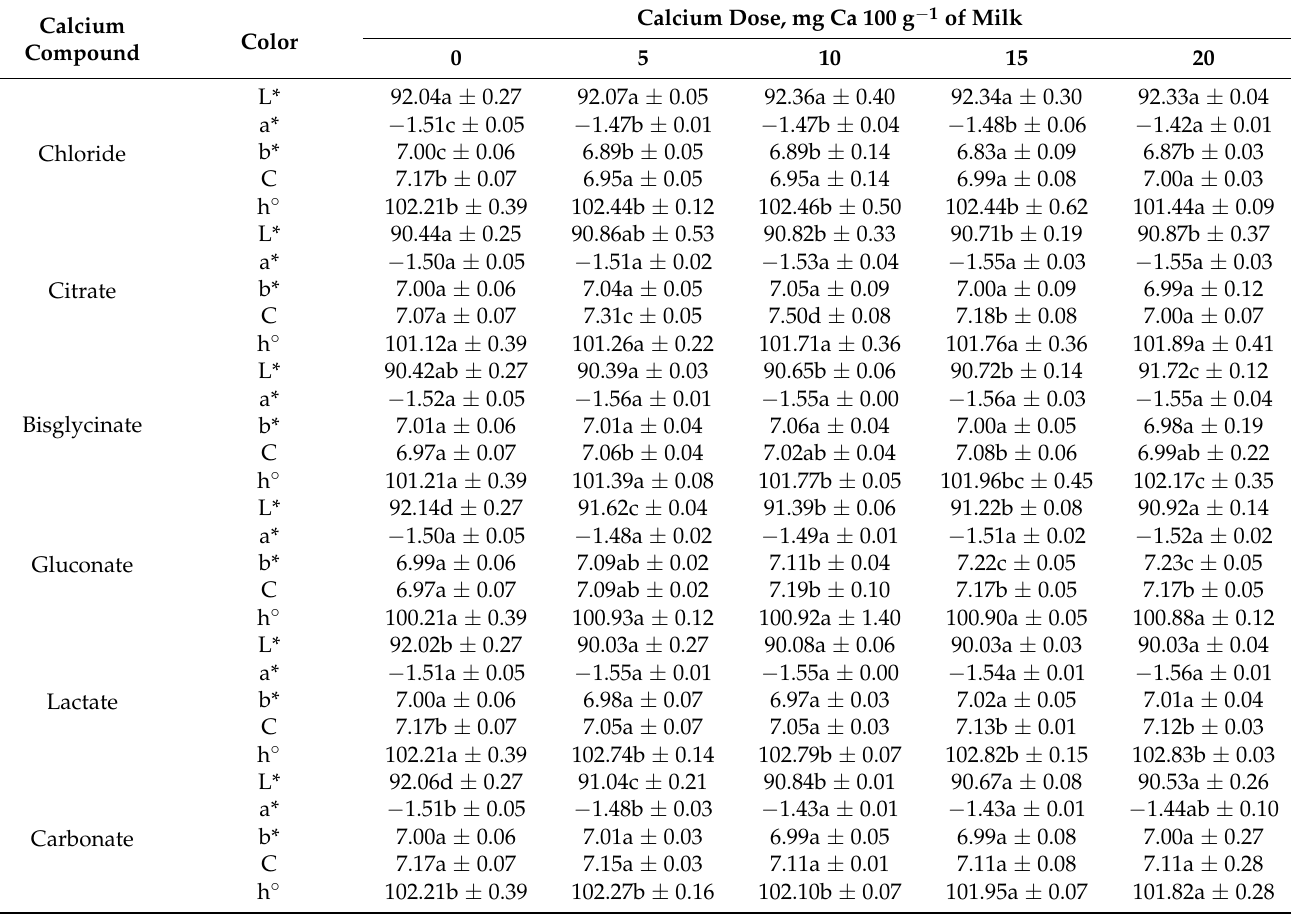
Table 6. Color of acid rennet goat’s milk